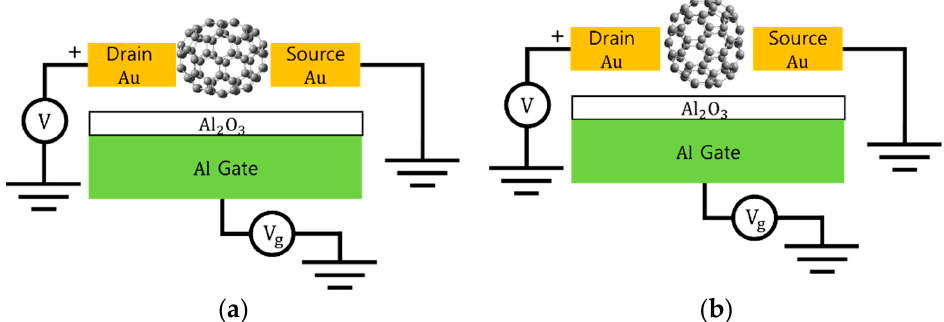
Figure 2. Schematic diagrams of idealized single-C 70 transistors. The spheroidal geometry of C 70 fullerene can face the electrodes in two types of major axis and minor axis directions: ( a ) when the minor axial direction of the C 70 faces the gate electrode surface and ( b ) when the major axial direction faces the gate electrode surface.